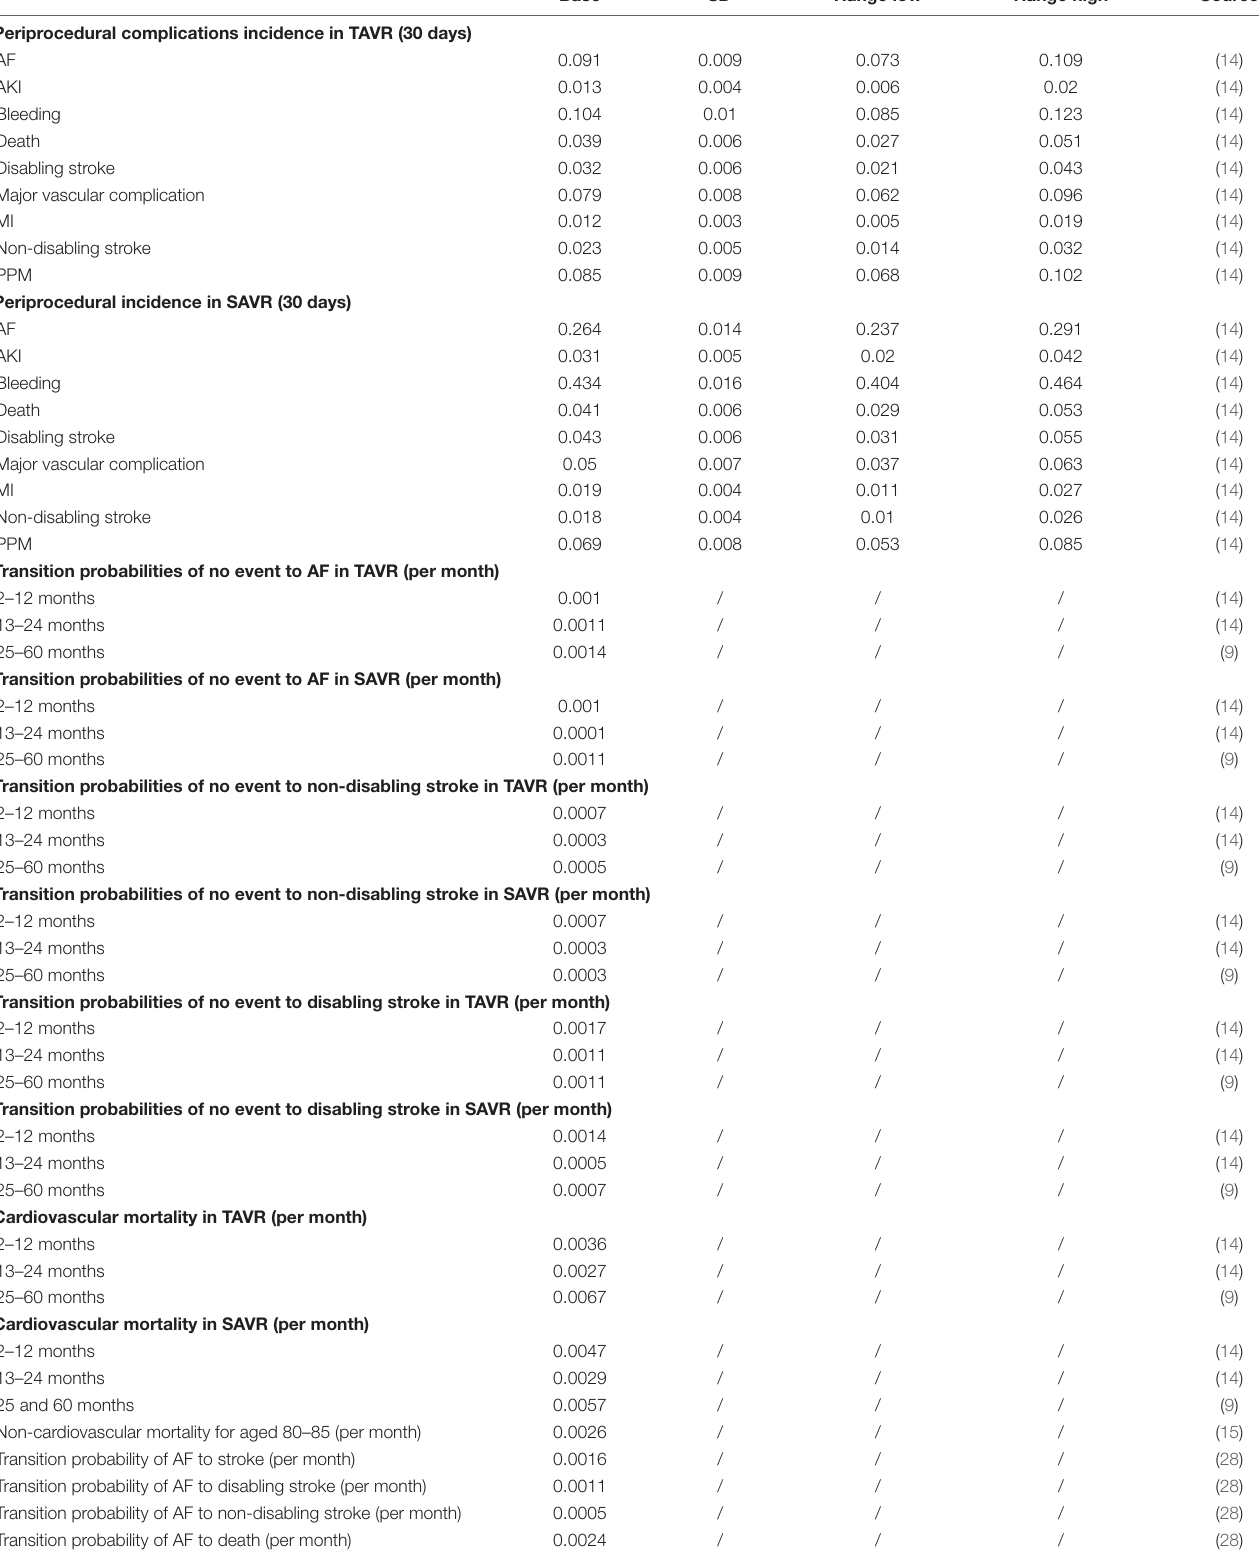
TABLE 1 | Periprocedural complications incidence and transition probabilities in the model. Base SD Range low Range high